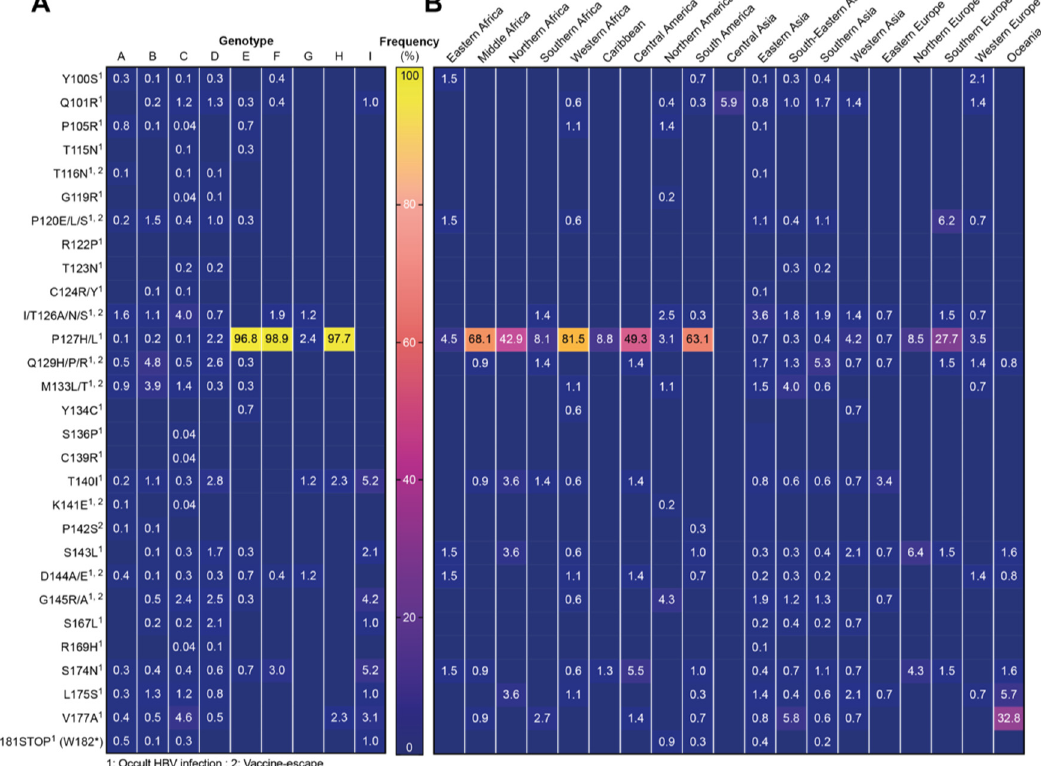
Figure 3. Frequency of clinically relevant HBsAg mutations. Numbers in the table indicate percentage of sequences containing the respective mutation within ( A ) each genotype or ( B ) different world regions. Blue fields without numbers represent a value of 0.0%. Superscript numbers indicate the clinical finding, which has been associated with the respective mutation.